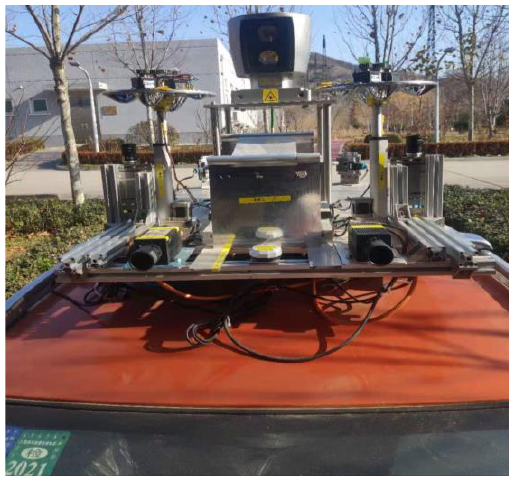
Figure 29. Unmanned systems experimental platform.